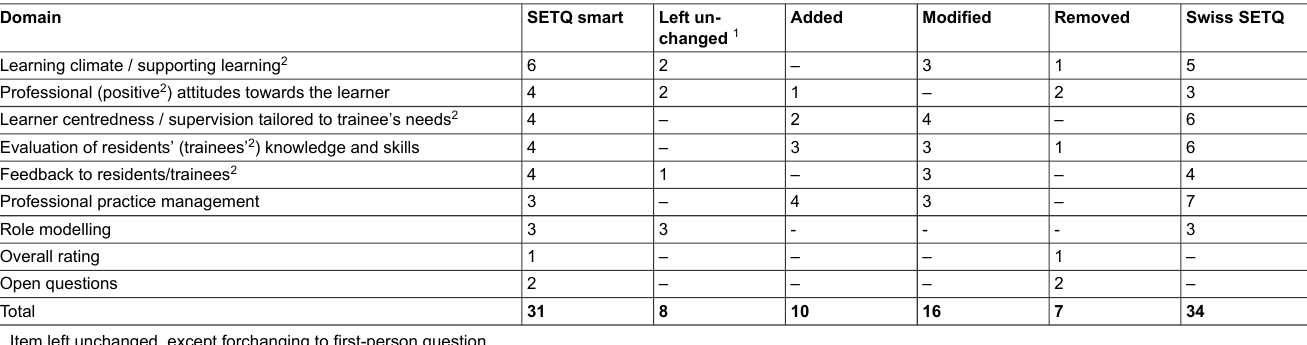
Table 1: Overview of altered items within SwisSETQ, compared with SETQ smart .